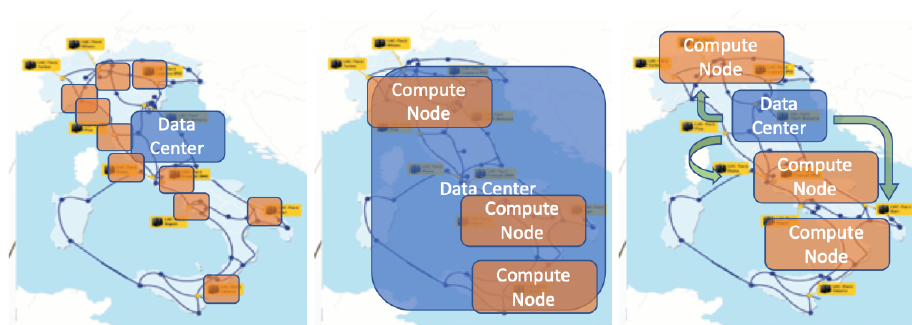
Figure 4. Possible Data Lake models for